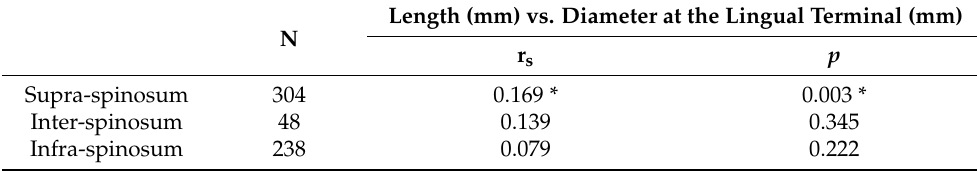
Table 5. Correlation between length (mm) vs. diameter at the lingual terminal (mm) for supra-inter and infra spinosum canals.